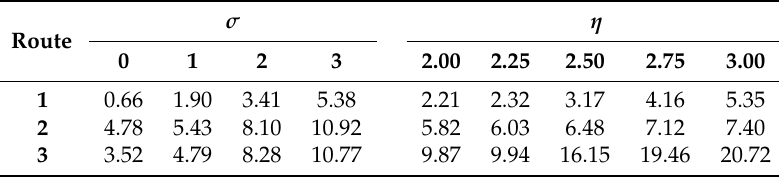
Table 3. RMSE (meters) in the three routes with different noise levels and different path loss exponents.